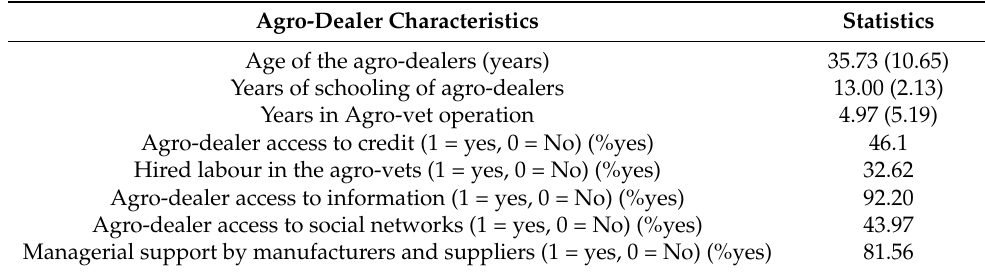
Table 1. Socio-economic characteristics of agro-dealers in Kirinyaga County ( n =